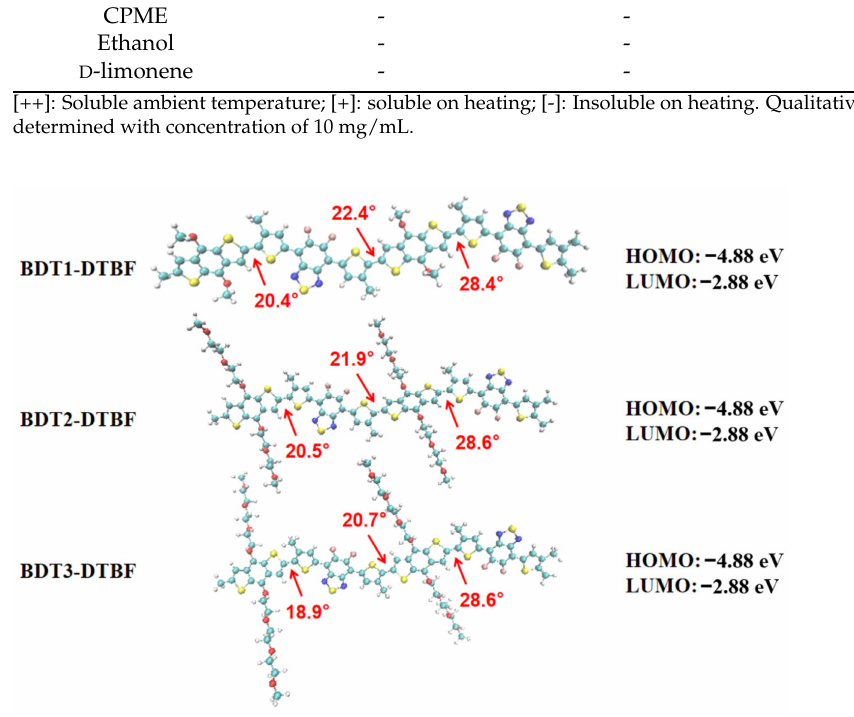
Figure 1. Simulation compounds, HOMO level and LUMO level of BDT1-DTBF, BDT2-DTBF and